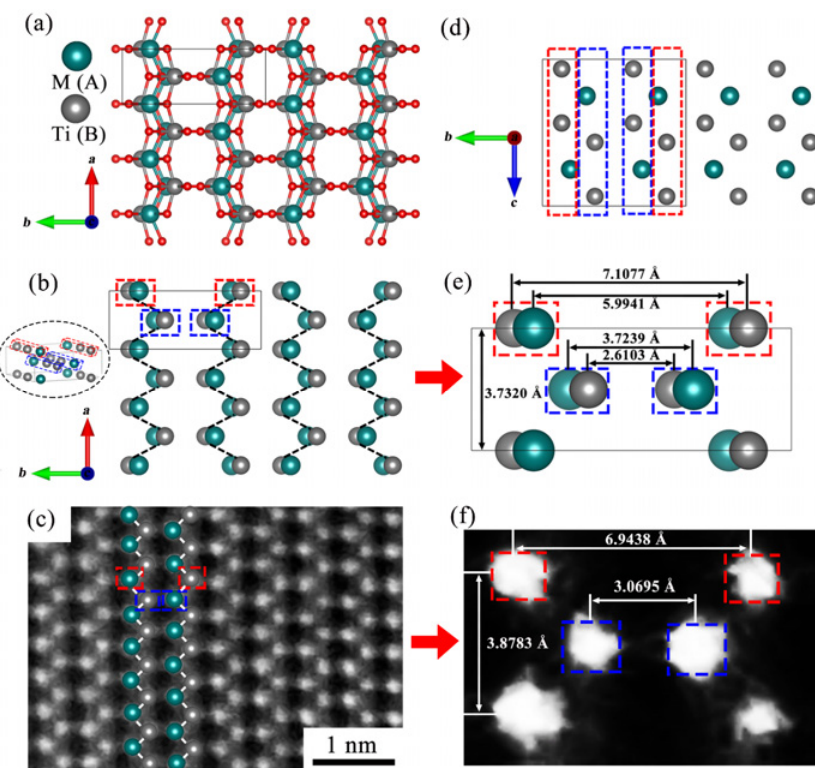
Fig. 12 (a, b, d) Theoretical crystal structures of the pseudobrookite phase. (c) HAADF image of high-entropy (Mg,Co,Ni,Zn)Ti 2 O 5 . (e) Single unit cell of theoretical crystal structure. (f) HAADF image at high magnification of high-entropy (Mg,Co,Ni,Zn)Ti 2 O 5 taken from the same